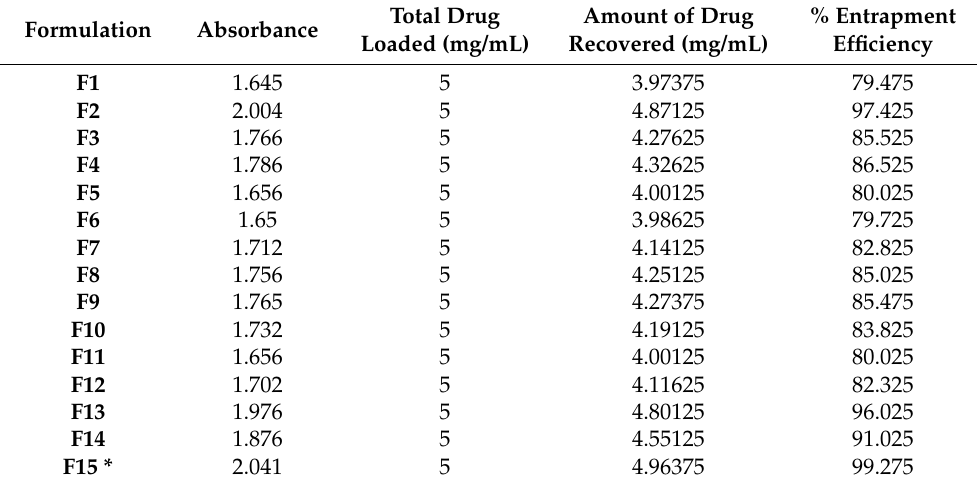
Table 2. Drug entrapment efficiency of prepared